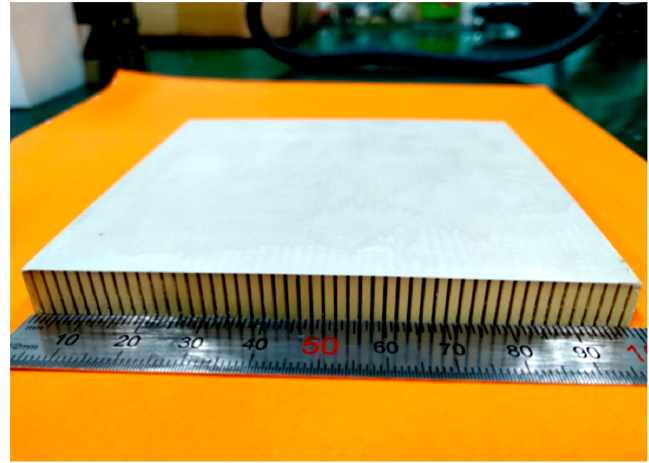
Figure 8. Photograph of the 1-3 piezoelectric composites.